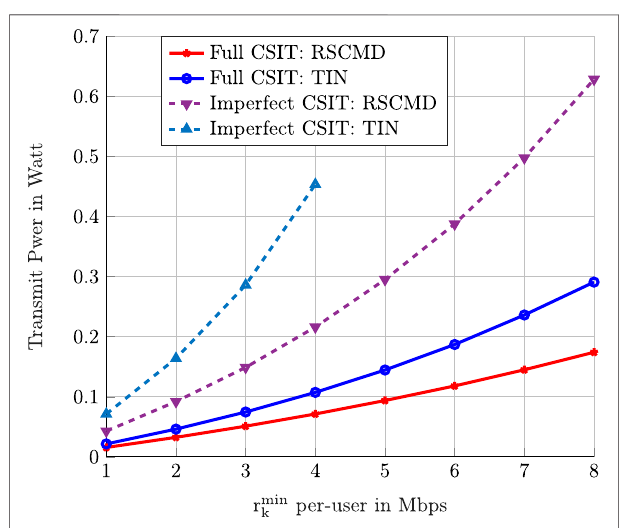
FIGURE 7 | The optimal value of the optimization problem (P 2 ) as a function of the minimum ergodic rate requested by users. We compare the performance of TIN and RS – CMD transmission strategies. Each BS has two antennas.